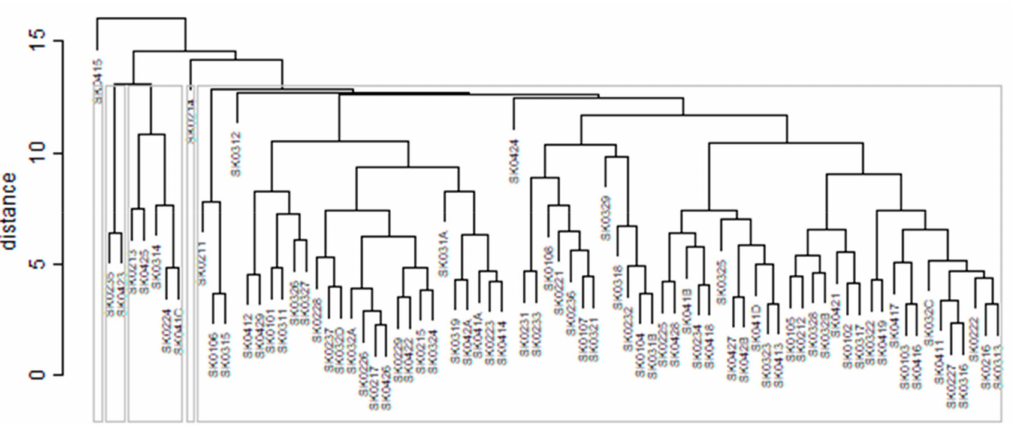
Figure 15. Preventable mortality dendrogram of the Districts for the female sex in the year 2015. Source: own elaboration by the authors.